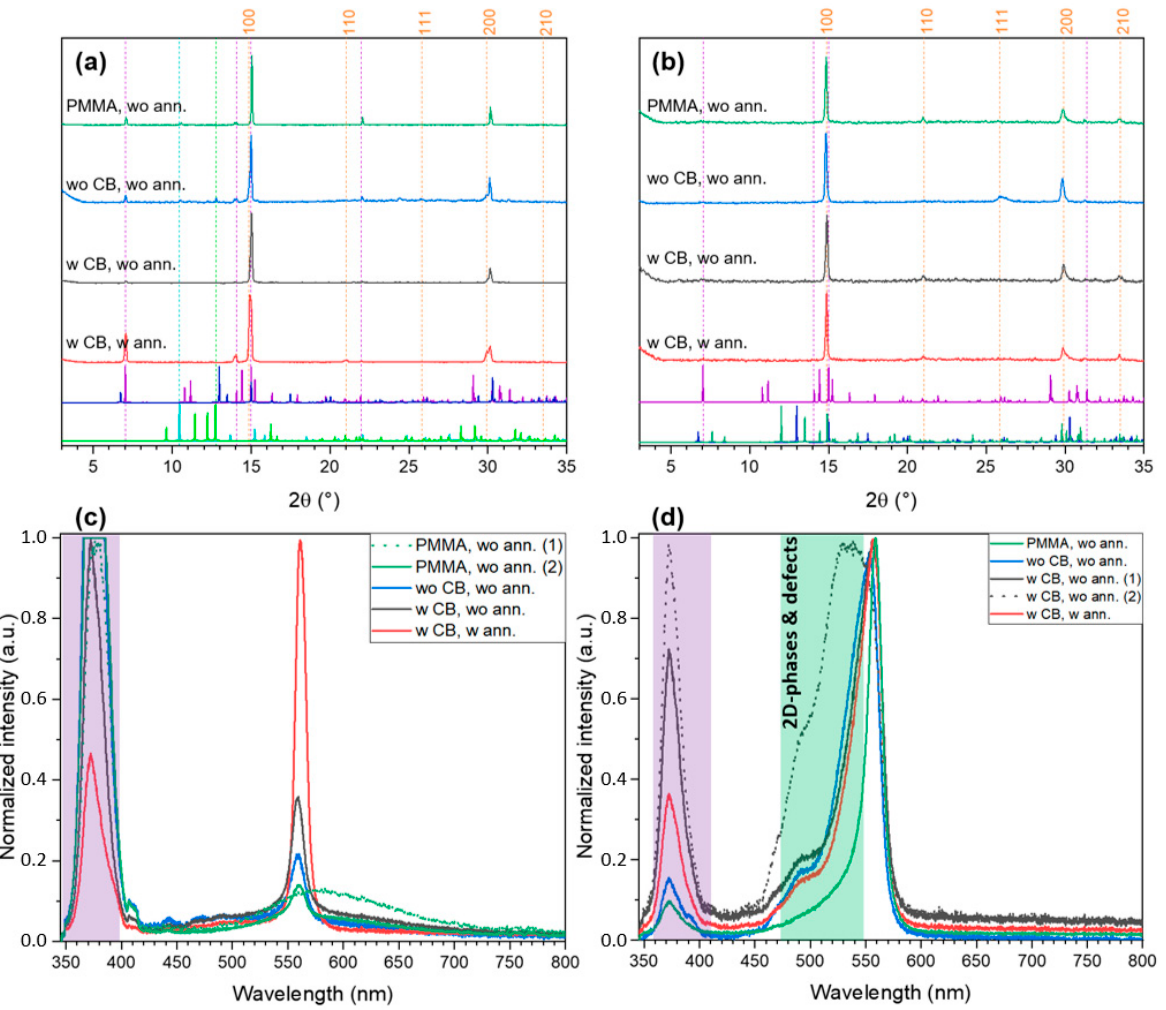
Figure 7. The XRD patterns ( a , b ) and PL spectra ( c , d ) of thin films with FABr:PbBr 2 2:1 spin-coated at different conditions from DMSO ( a , c ) and DMF ( b , d ) solutions. The dashed orange lines denote the reflections of FAPbBr 3 perovskite, other dashed lines indicate the positions of the most relevant reflections corresponding to reference XRD pattens plotted below. ( t- FA 2 PbBr 4 by vivid violet, m- FA 2 PbBr 4 by dark blue, FAPbBr 3 ·DMSO by lime green, FA 2 PbBr 4 ·DMSO by turquoise). For the highest used FABr:PbBr 2 ratio ( r = 3), crystallization from DMSO starts with intermediate formation of the t- FA 2 PbBr 4 layered phase which recrystallizes and reacts with FABr excess under annealing to form chained 1D FA 3 PbBr 5 phase (Figure 8a). In the case of DMF, the FA 3 PbBr 5 crystallizes directly from the solution (no intermediate phases were identified according XRD, Figure 8b). Using of antisolvent leads to texturing of the films along (002) and (004) planes resulting in XRD pattern asimilar to 3D perovskite (Fig- ure 8b) while it is not present in the films with r = 3: 1 because of their white color and the